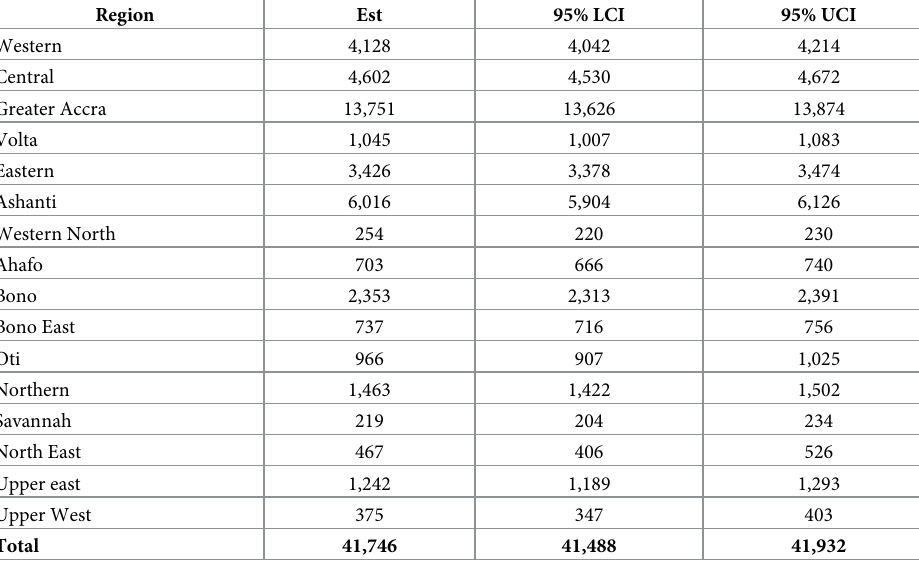
Table 1. Population size of roamer FSW using capture-recapture by region in Ghana, 2020. Region Est 95% LCI 95% UCI